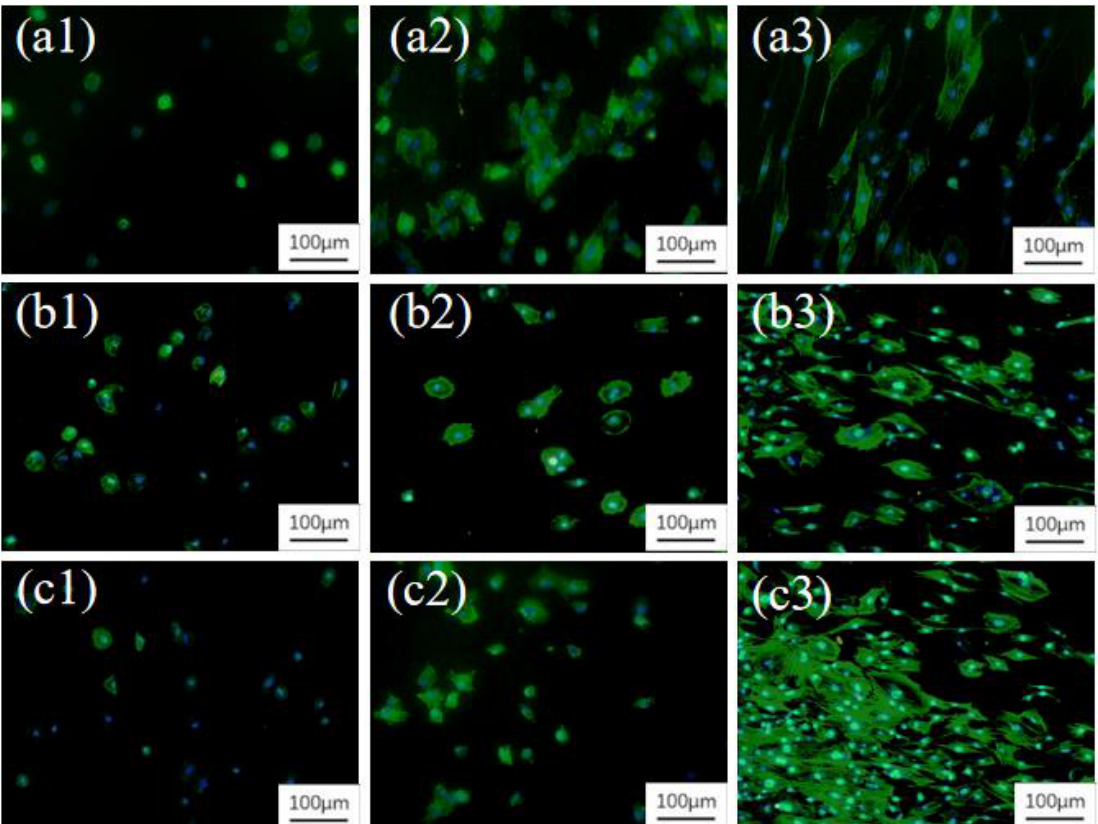
Figure 14. Cytoskeleton of MC3T3 cell on cp-Ti and TNZ-xCu (T6-2h) samples for 1 h, 4 h, and 24